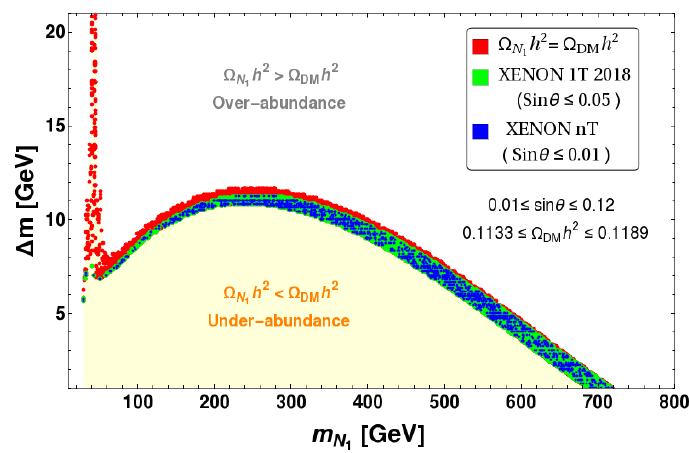
Figure 3 . Relic density allowed (red points) and direct detection XENON 1T (green points), f XENON nT (blue points) allowed parameter space for single component fermion DM ( N 1 ) is shown g in m N (cid:1) m plane. Under abundance ((cid:10) N h 2 < (cid:10) DM h 2 ) (yellow region below the red points) and 1 (cid:0) 1 over-abundance ((cid:10) N h 2 > (cid:10) DM h 2 ) (the region above the red points) are also indicated. (cid:10) DM h 2 1 range is mentioned in the (cid:12)gure inset and also in eq.